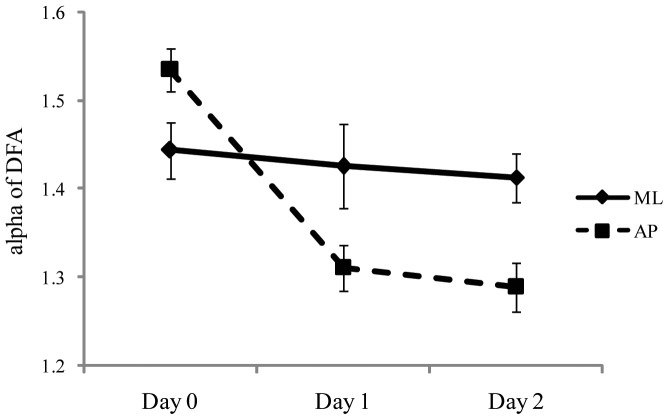
Experiment 2: Meanα of DFA for the AP and ML axes as a function of days.The figure illustrates the statistically significant interaction between axes and days. The error bars represent standard error of the mean.